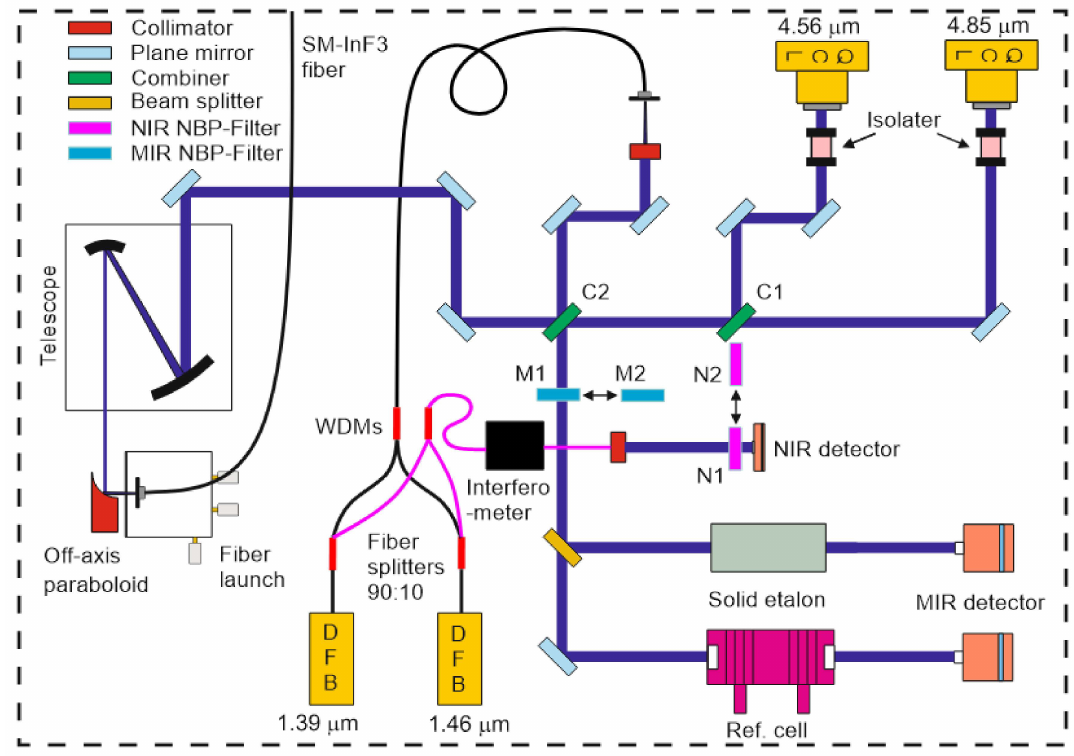
Figure 4. Optical layout of the sending